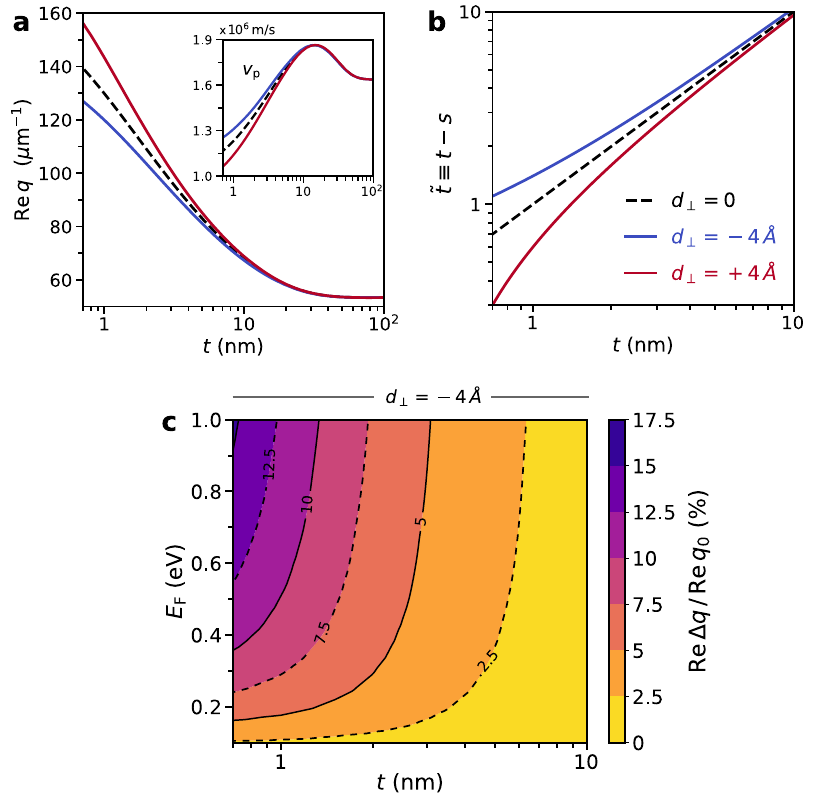
Fig. 4 Nonclassical corrections probed by AGPs. a AGP ’ s wavevector as a function of the graphene – metal separation t , contrasting the metal ’ s response based on classical ( d ⊥ = 0) and quantum ( d ⊥ = ±4 Å ) treatments. Inset: corresponding group velocity v p ¼ ∂ ω = ∂ q j q ¼ q ð ω renormalized graphene – metal separation ~ t (cid:2) t (cid:3) s versus t . Setup parameters: r s = 3, _ γ m = 0.1eV, ϵ d = 4, E F = 0.3eV, and _ γ = 8meV; we assume an excitation at λ 0 = 11.28 μ m ( _ ω 0 ≈ 110meV or f 0 ≈ 26.6THz) 32 . c Relative quantum shift of the AGP wavevector, Re Δ q = Re q 0 , with Δ q ≡ q 0 − q where q 0 and q denote the AGP wavevector associated with d = 0 and d = − 4 Å , respectively. The results presented in both a and c are based on the exact, numerical ⊥ ⊥ solution of Eq.